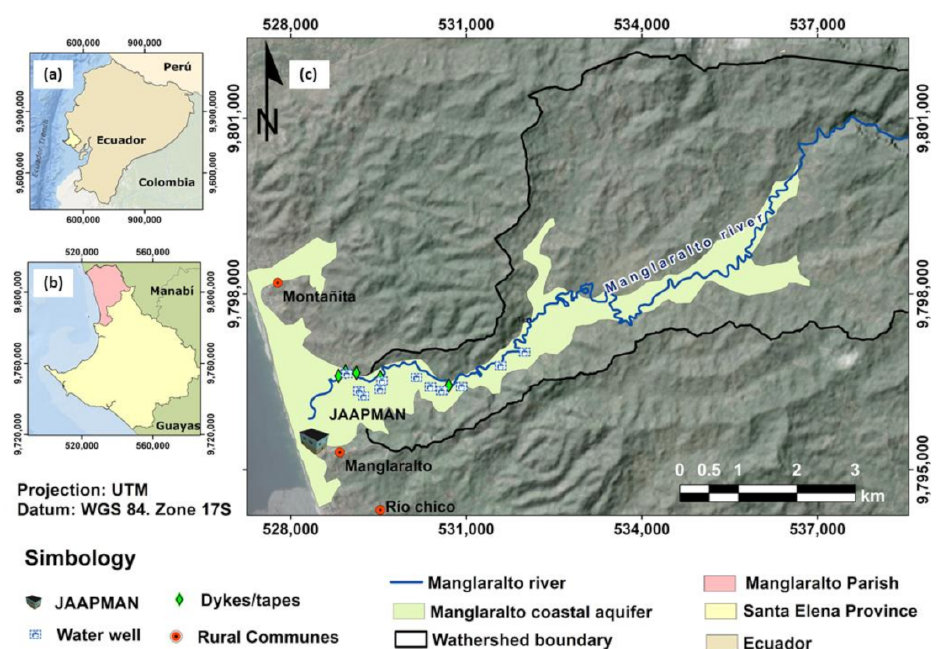
Figure 1. ( a ) Study area location in Ecuador. ( b ) Parishes of the province of Santa Elena and location of the parish of interest. ( c ) Zone of the aquifer associated with the Manglaralto River, including the design of ‘tapes’ (word of traditional/ancestral knowledge) or artisanal